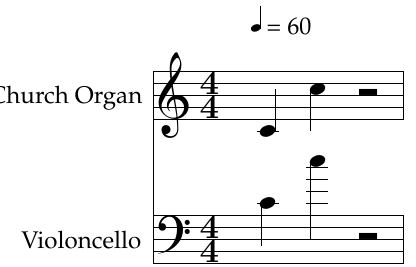
Figure 3. Resulting score from Iteration 2 (see Audio S3).